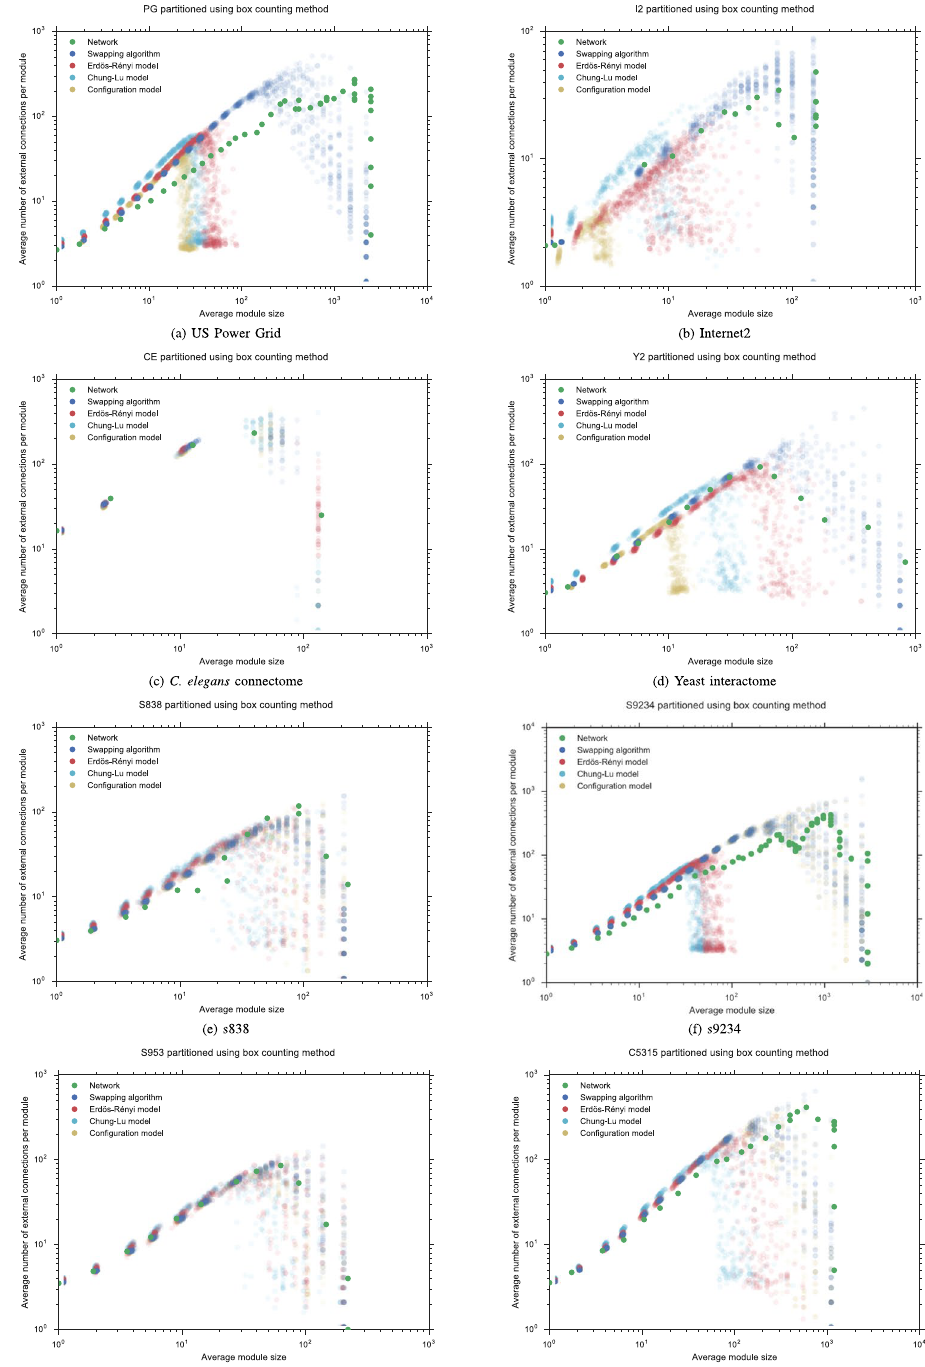
Figure 4. The box counting method is applied to obtain the Rent characteristics of each empirical network and each random network (SA), (CM), (CLM) and (ER) with the same order and